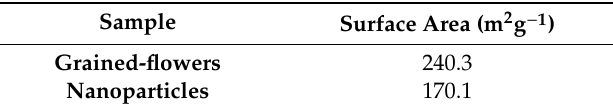
Table 1. Surface area of the synthesized NiO samples.